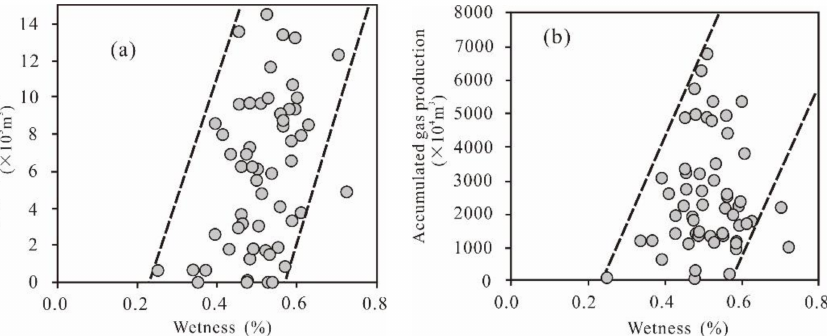
Figure 7. Relationship between the wetness and the production of shale gas in Longmaxi Formation of Sichuan basin. ( a ) Relationship between the wetness and the average production per month of shale gas in Longmaxi Formation of Sichuan basin. ( b ) Relationship between the wetness and the accumulated production of shale gas in Longmaxi Formation of Sichuan